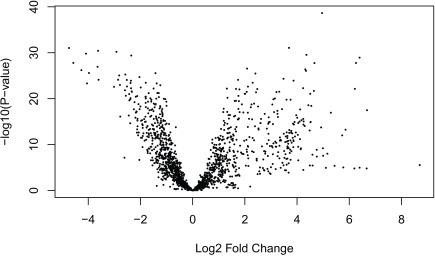
Volcano plot of the expressed regions level data.Testing for prenatal and postnatal DE adjusting for sex and RIN.